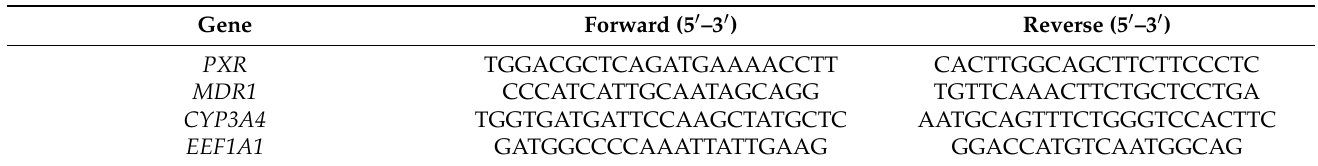
Table 1. Nucleotide sequences of primers for amplification of the target cDNA in quantitative RT-PCR.